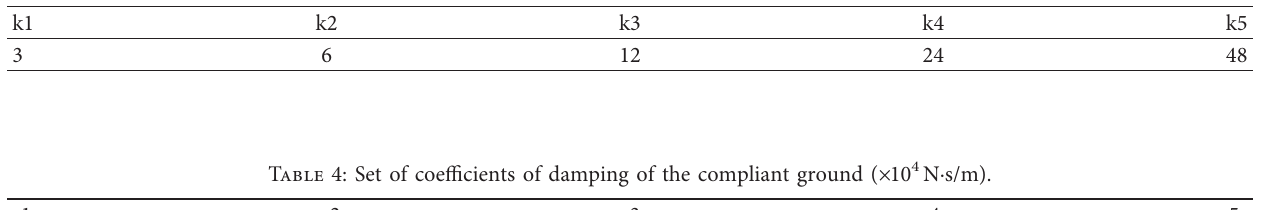
Table 3: Set of coefficients of stiffness of the compliant ground ( × 10 4 N/m).